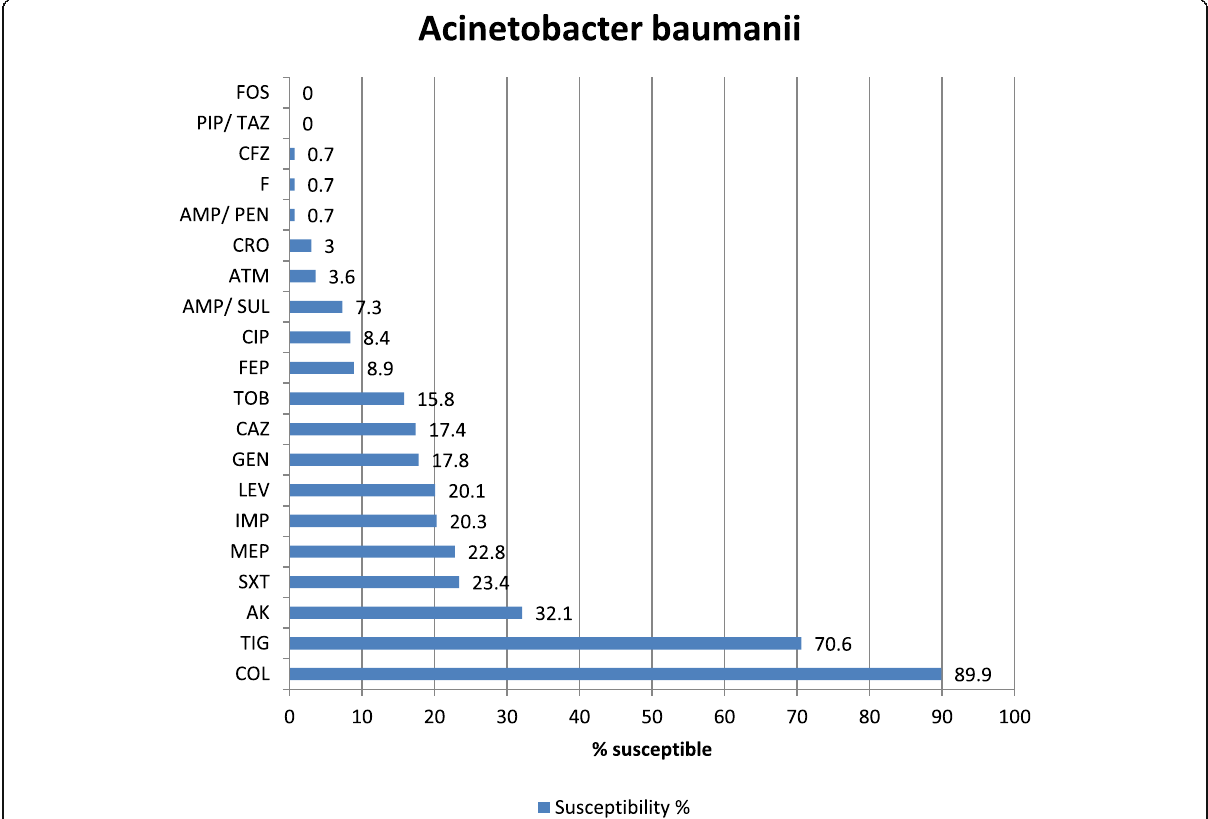
Fig. 4 Antibiotic susceptibility of Acinetobacter baumanii . AMP/PEN ampicillin/penicillin, CFZ cefazolin, FEP cefepime, CRO ceftriaxone, AMP/SUL ampicillin/sulbactam, F nitrofurantoin, PIP/TAZ pipracillin/tazobactam, CIP ciprofloxacin, ATM aztreonam, TOB tobramycin, CAZ ceftazidime, SXT sulfa-trimethoprim, MEP meropenem, IMP imipenem, ERT ertapenem, GEN gentamycin, AK amikacin, LEV levofloxacin, FOS fosfomycin, TIG tigecylcine, COL